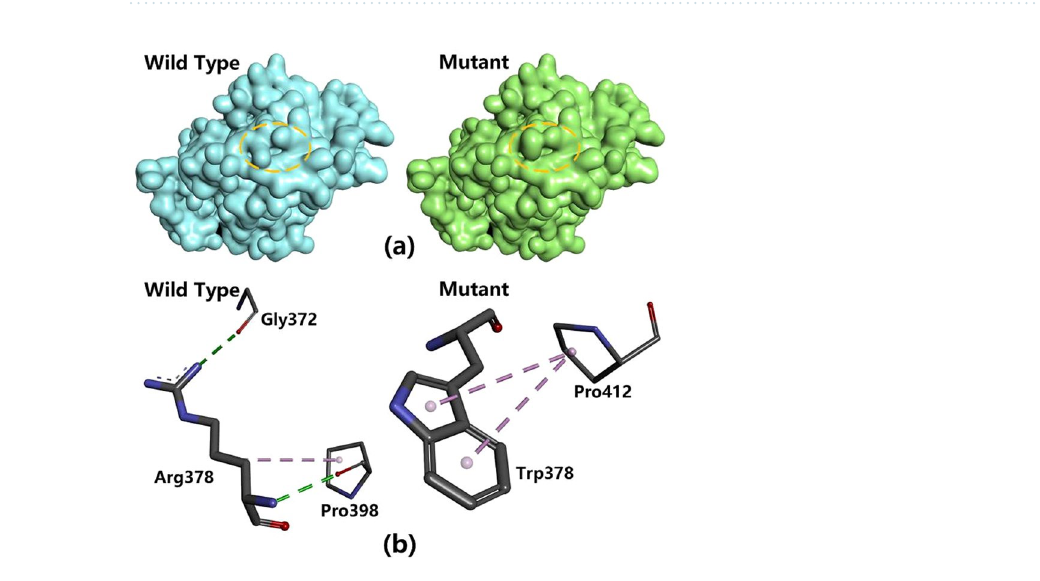
Figure 5. Predicted structural changes based on the missense mutation R377W in the giant panda HSF4 protein. ( a ) Changes in surface structure visualized using Discovery Studio Visualizer. ( b ) Interactions between amino acid side chains predicted using THREADER and